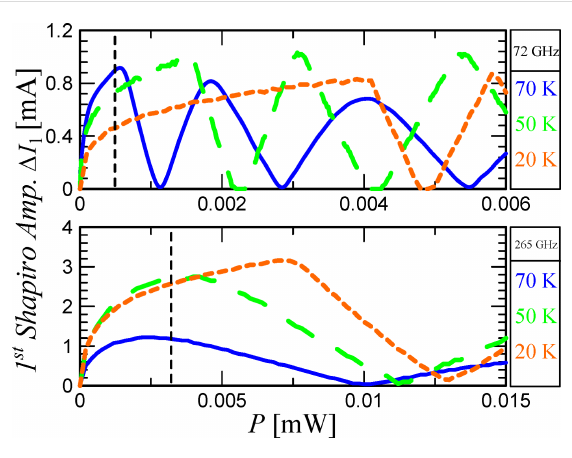
Figure 5: The first Shapiro step as function of P mw at three tempera- tures and under a signal at 72 GHz (upper graph) and 265 GHz (lower graph). The black dashed lines indicate the power levels from the ex-